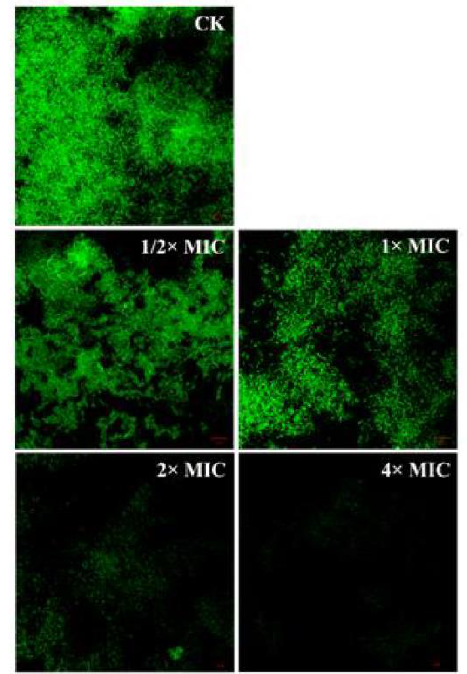
Figure 4. Inhibitory effect of lemon verbena essential oil on Pseudomonas D4 biofilm. CLSM photo of Pseudomonas D4 treated with different concentrations of lemon verbena essential oil (0 × MIC, 1/2 × MIC, 1 × MIC, 2 × MIC, and 4 × MIC).